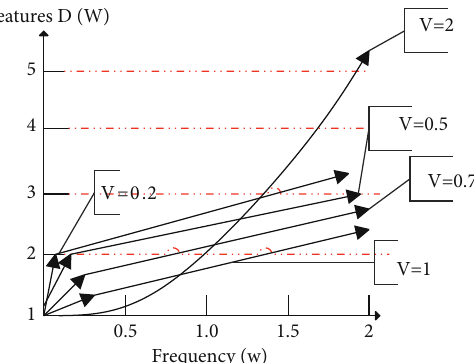
Figure 4: Fractional differential amplitude-frequency character- istic